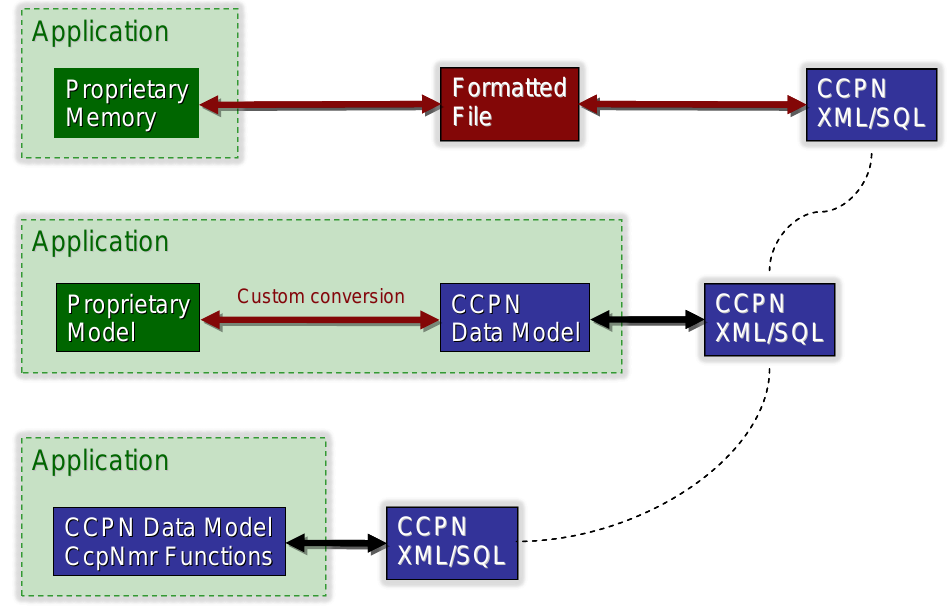
Supplementary Figure 7: Software integration approaches: Top: Data exchange through proprietary files. This approach is possible without modifying the application code, but requires continued maintenance of program-specific I/O and mappings. Integration of application output is often problematical, as output data items can be hard to match with input data items, let alone with the CCPN objects that gave rise to them. Middle: In-memory data conversion. Requires a program-specific conversion layer, but relies on existing CCPN (and often application) I/O. Integration is easier as all information relative to data flow remains available. Bottom: Direct data access through CCPN API. Does away with the need for conversion or separate I/O code. All information is connected to the data standard throughout. Requires the application to be (re)written specifically for the data